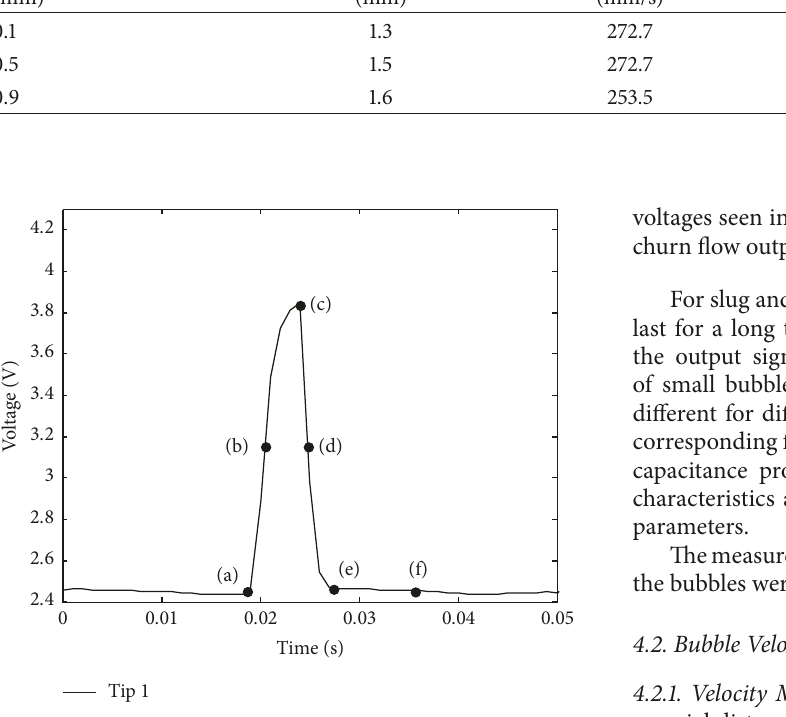
Figure 14: Output signal of a needle-contact capacitance probe with a 0.1mm inner diameter